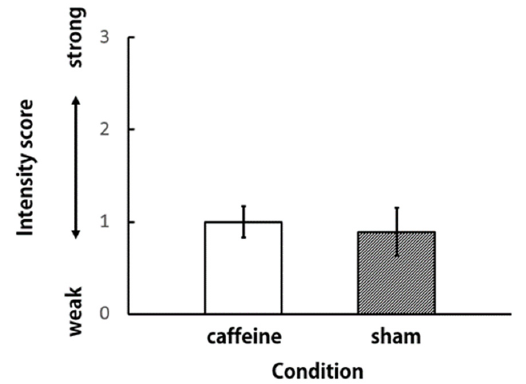
Figure 4. Intensity score for the aroma of vapors ( N = 9).